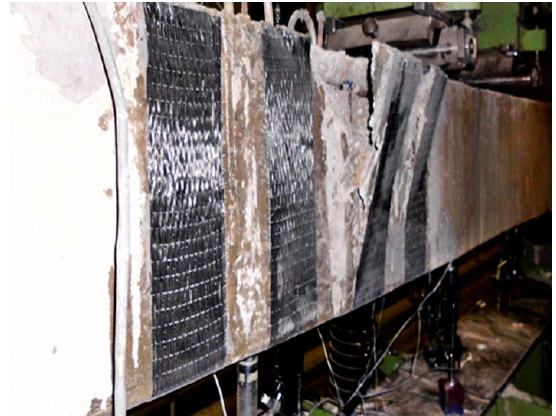
Figure 6. Load versus CFRP strain for strengthened